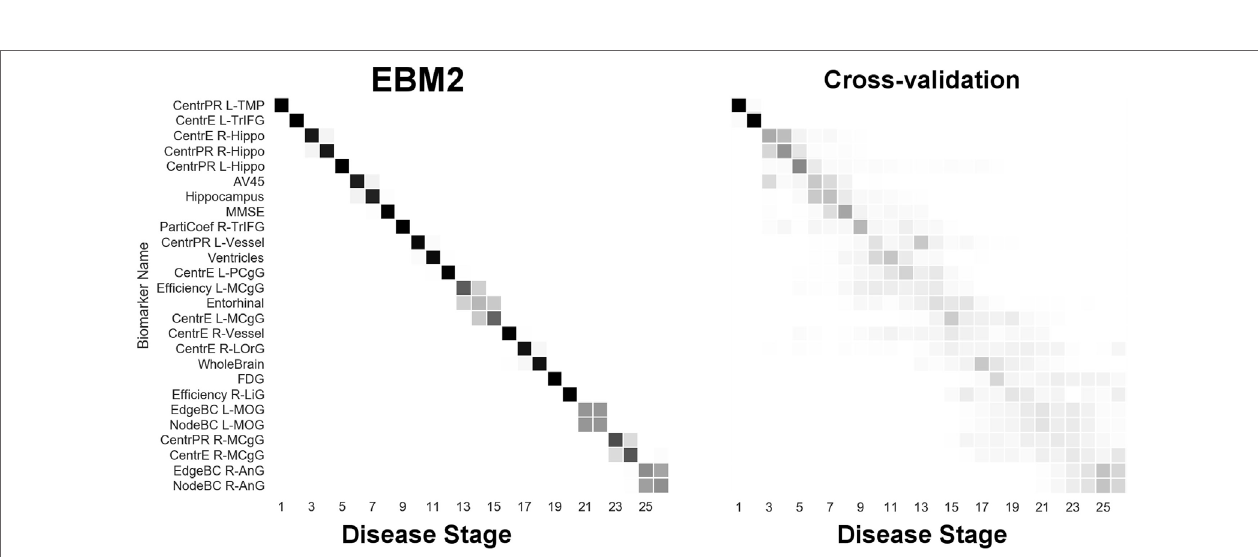
FigUre 7 | EBM for regional centrality in the brain’s anatomical network, along with selected standard (non-network) biomarkers, built on data from our anatomical connectome cohort, The168 . Left panel: left-right positional variance of the maximum-likelihood sequence. Right panel: cross-validation of the sequence from bootstrapping. Abbreviations: CentrPR, PageRank centrality; CentrE, eigenvector centrality; PartiCoef, participation coefficient; EdgeBC, edge betweenness centrality; NodeBC, node betweenness centrality; L, left; R, right; TMP, temporal pole; TrIFG, triangular inferior frontal gyrus; Hippo, hippocampus; PCgG, posterior cingulate gyrus; MCgG, middle cingulate gyrus; LOrG, lateral orbital gyrus; LiG, lingual gyrus; MOG, middle occipital gyrus; AnG, angular gyrus.